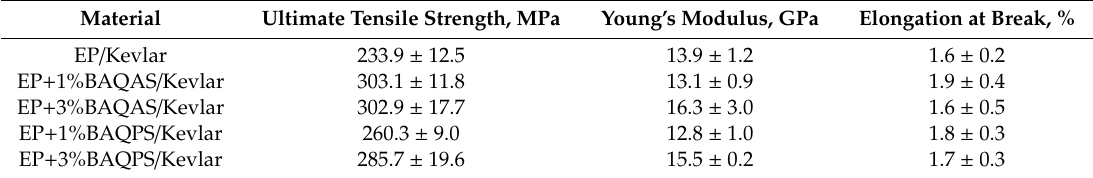
Table 1. The tensile properties of Kevlar reinforced composites 1 . Epidian ® 624 (EP), bentonite from Armenia (BA) modified with phosphonium salts (BAQPS) and modified with quaternary ammonium salts (BAQAS).